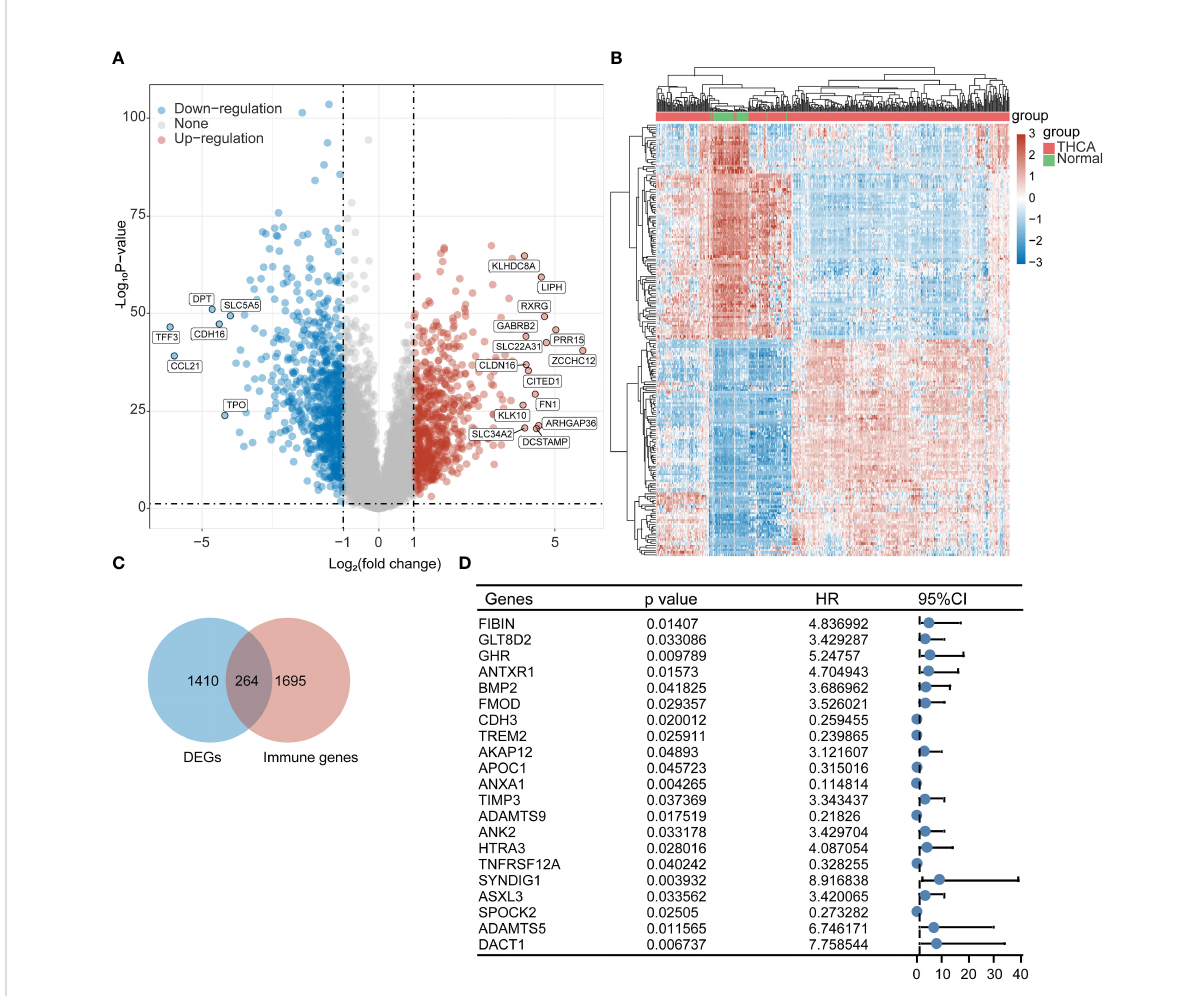
FIGURE 1 Screening of immune-related prognostic genes in DEGs. (A) Volcano plot, (B) Heat map, (C) Wayne plot, and (D) 21 differential genes with prognostic